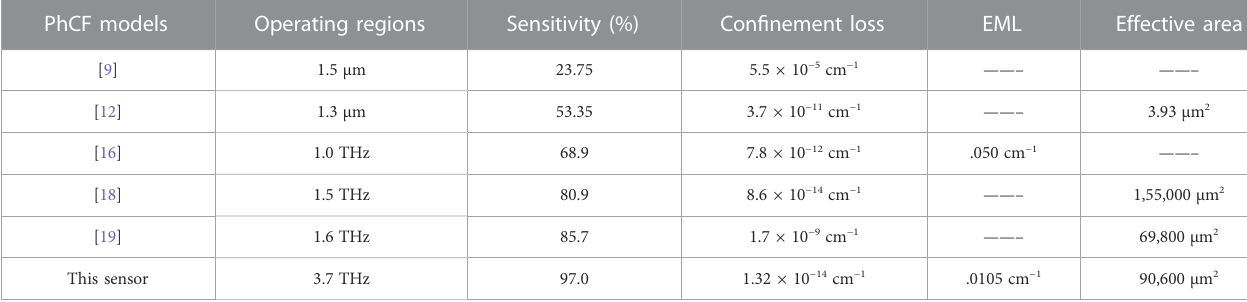
Figure 2B. The lower the strut size the higher the CPF. We also varied increasing with increasing frequencies.